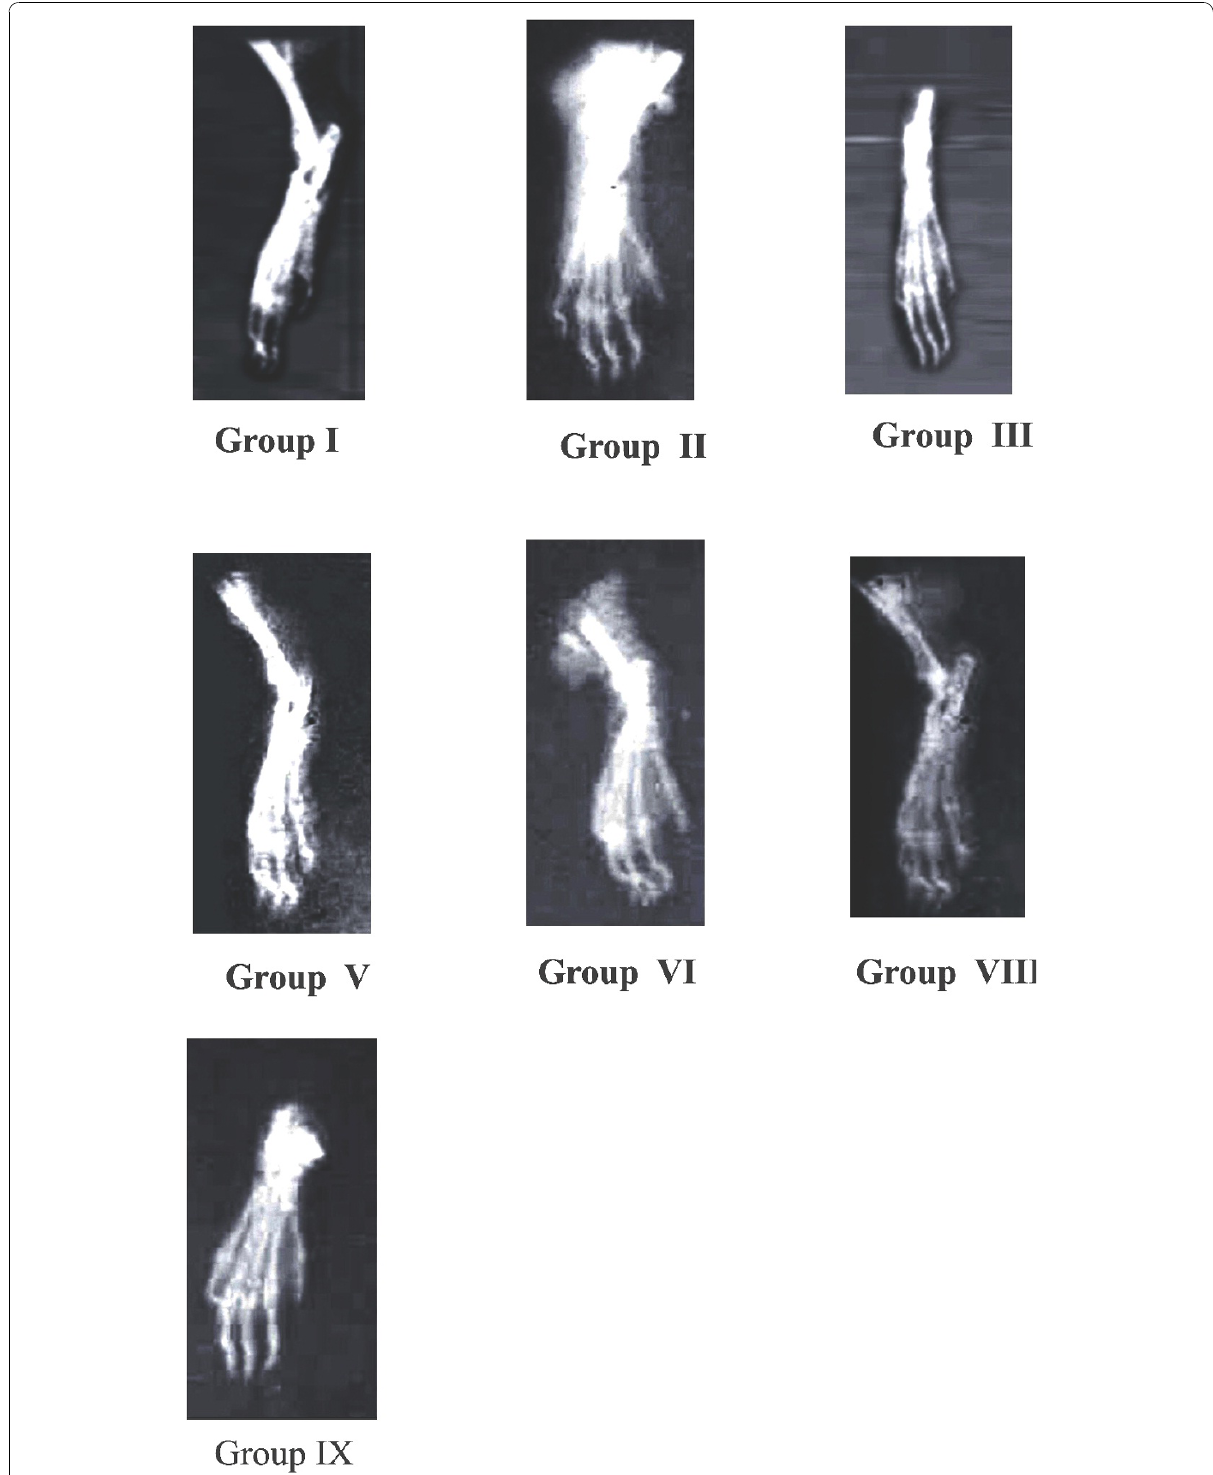
Figure 3 Radiology of hind legs in adjuvant induced arthritic rats